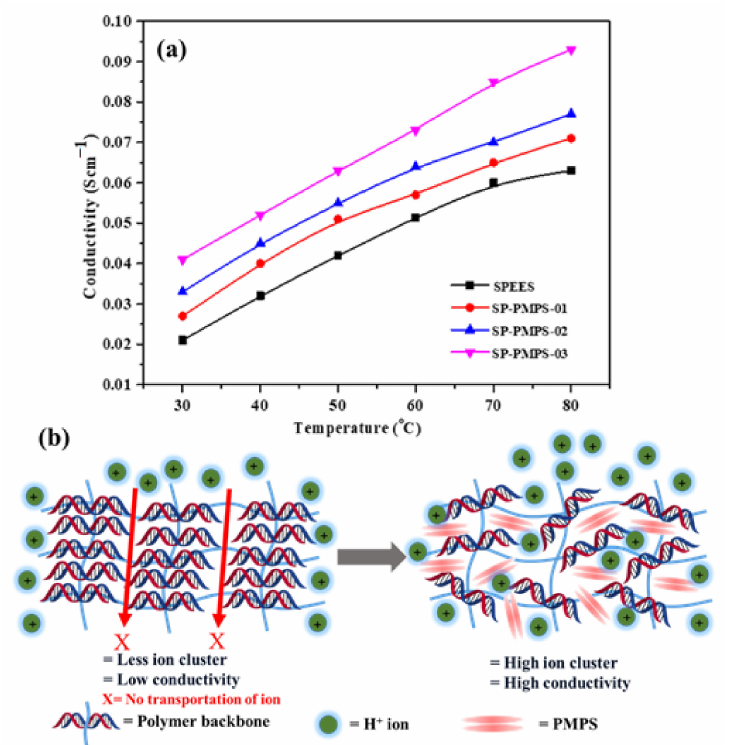
Figure 4. ( a ) Proton conductivity of different membranes with temperature, ( b ) mechanism of enhanced ionic conductivity.